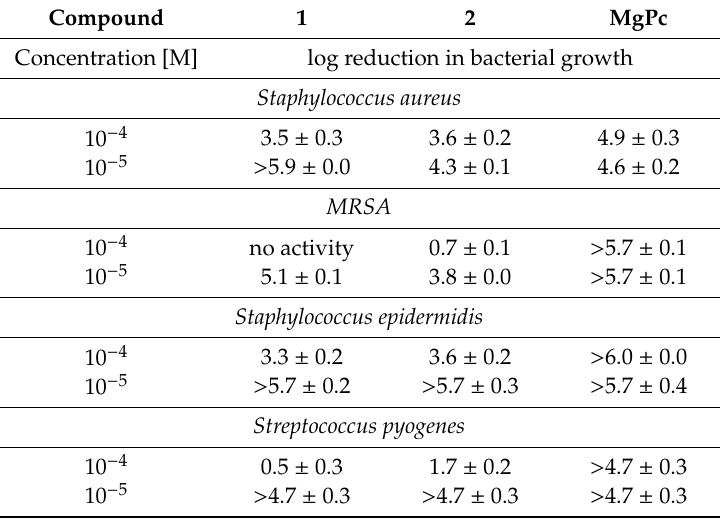
Table 3. Photodynamic reduction of the bacterial growth by the studied